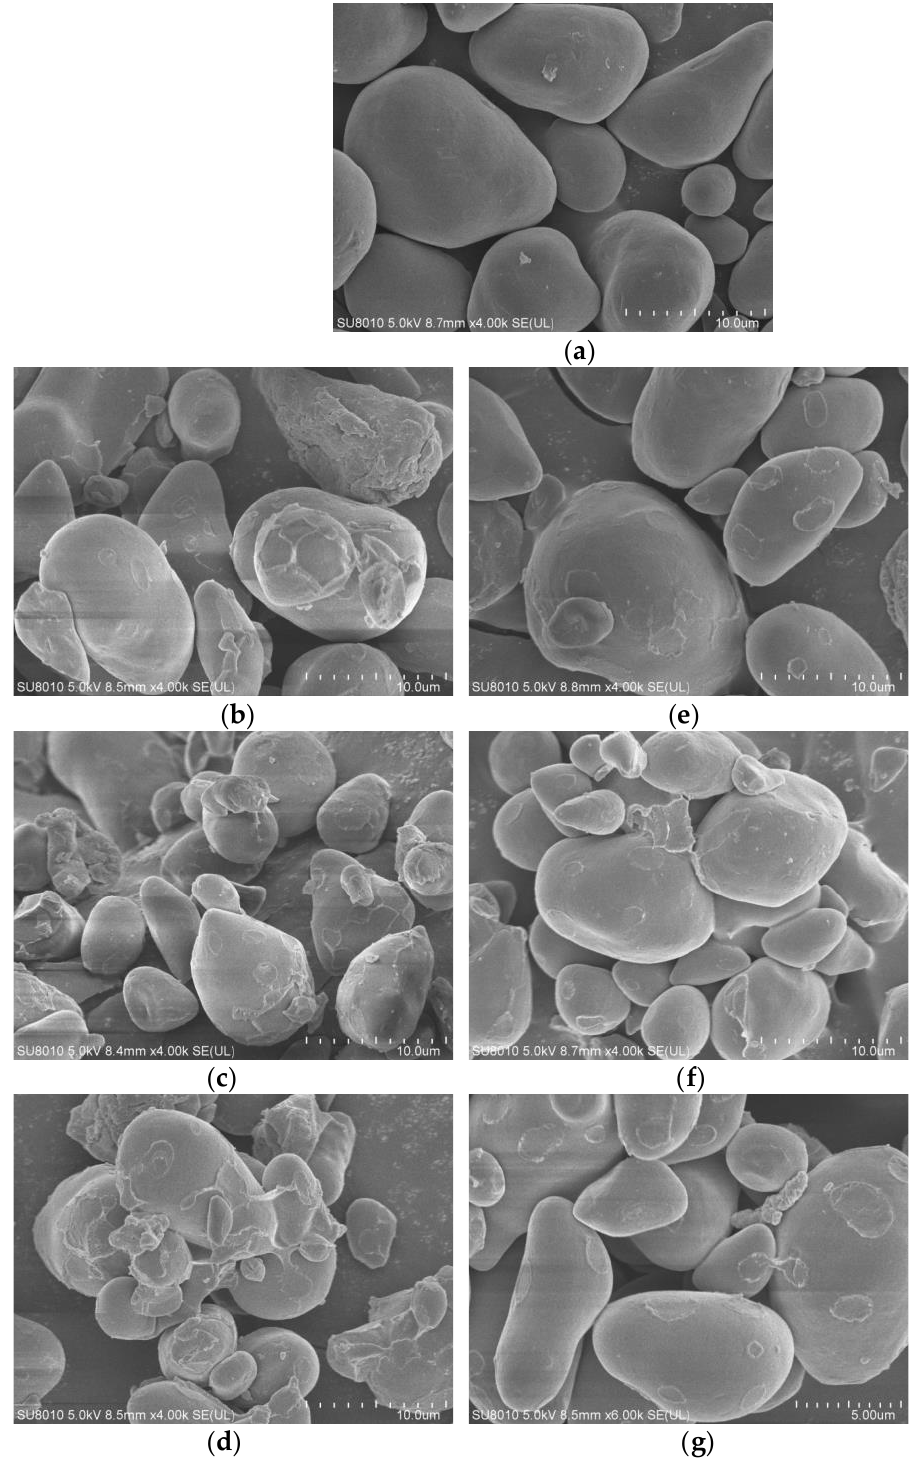
Figure 1. Scanning electron micrographs (SEM) of native, phosphorylated and acetylated chestnut starch (4000 ×, 6000 ×): ( a ) NS; ( b ) PCS-1; ( c ) PCS-2; ( d ) PCS-1; ( e ) ACS-1; ( f ) ACS-2; ( g ) ACS-3.